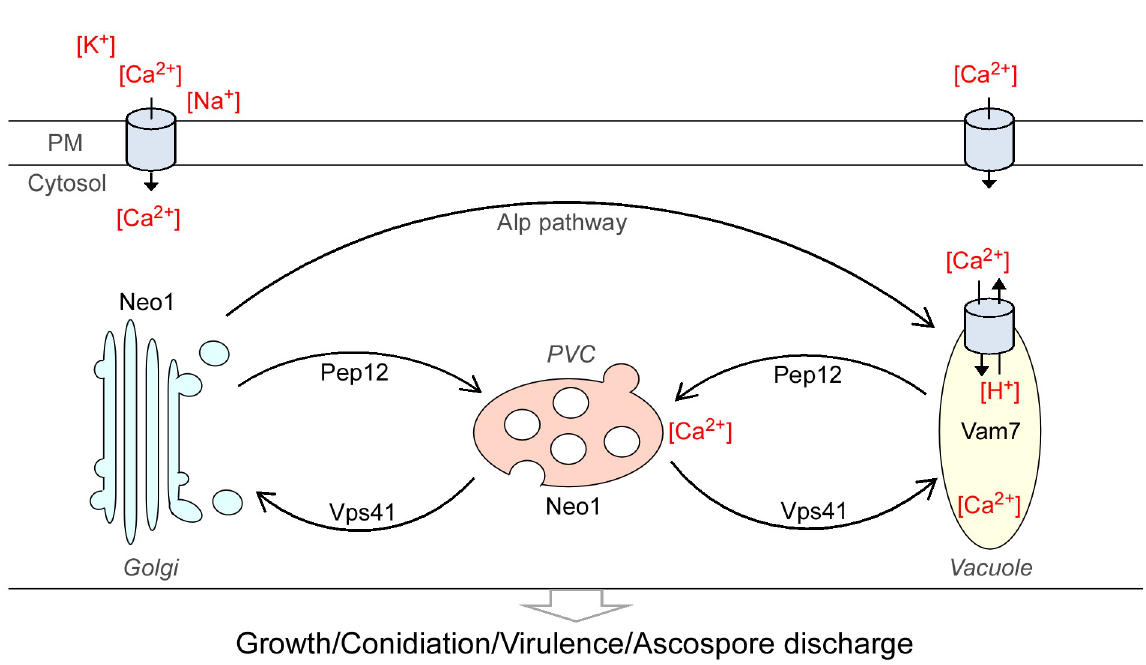
Fig 12. A proposed model for FgPep12-Vam7-Neo1 during the development, plant infection and ascospore discharge in F . graminearum .